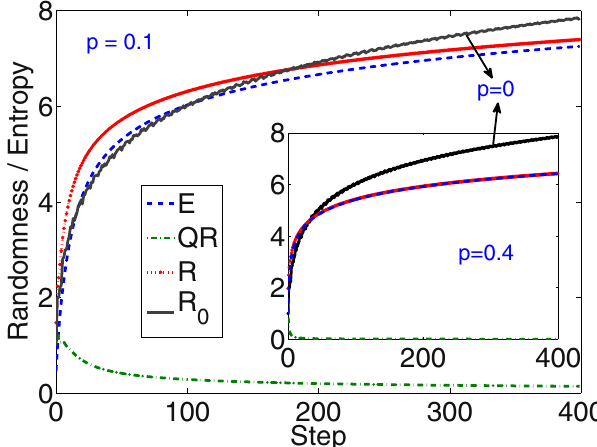
Figure 5. Randomness with number of steps in standard DTQW in presence of bit flip noise in coin space. With increase in noise some decrease in randomness is seen. The randomness in system with noise will have contribution from both, quantum origin as well as noise. To show that we have plotted randomness ( R ) for noiseless evolution and for evolution with different noise level p . The van Neumann entropy ( E ) and the randomness of quantum origin is also shown. Though overall randomness does not see a significant decrease, a substantial decrease in randomness from quantum origin is